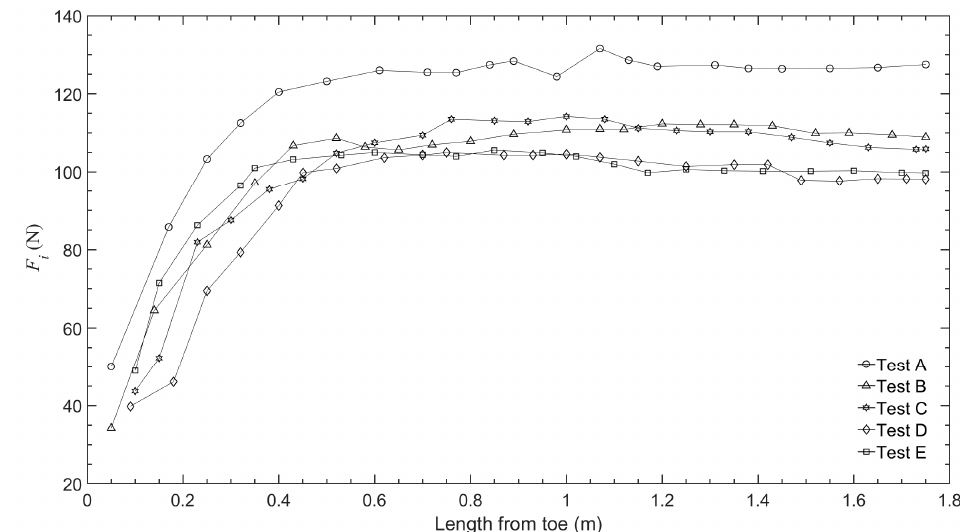
Figure 4. Measured axial load at the toe section of the experimental models during riprap layer building.